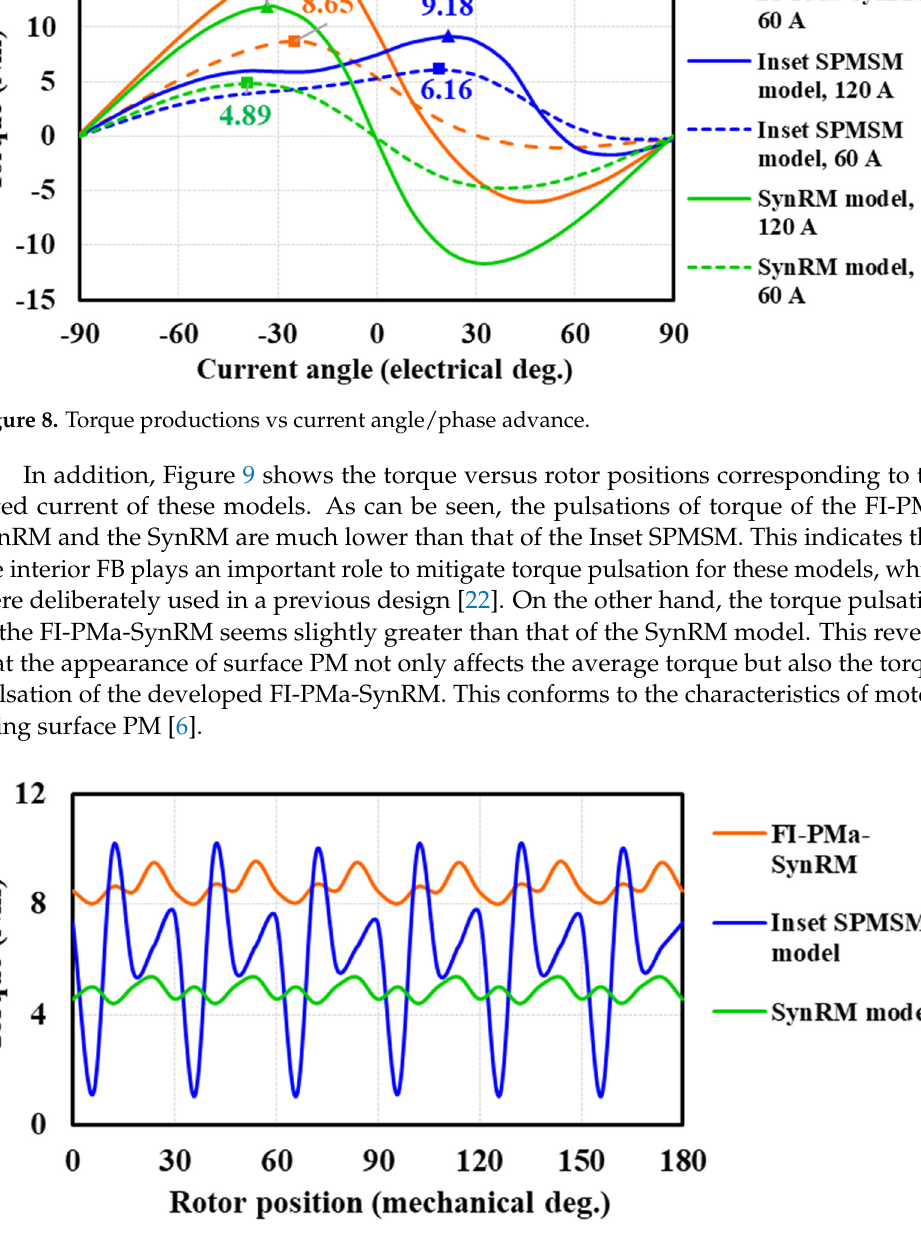
Figure 7. Inductance and saliency vs current magnitude for FI-PMa-SynRM (1) , Inset SPMSM model (2) , and SynRM model (3) .